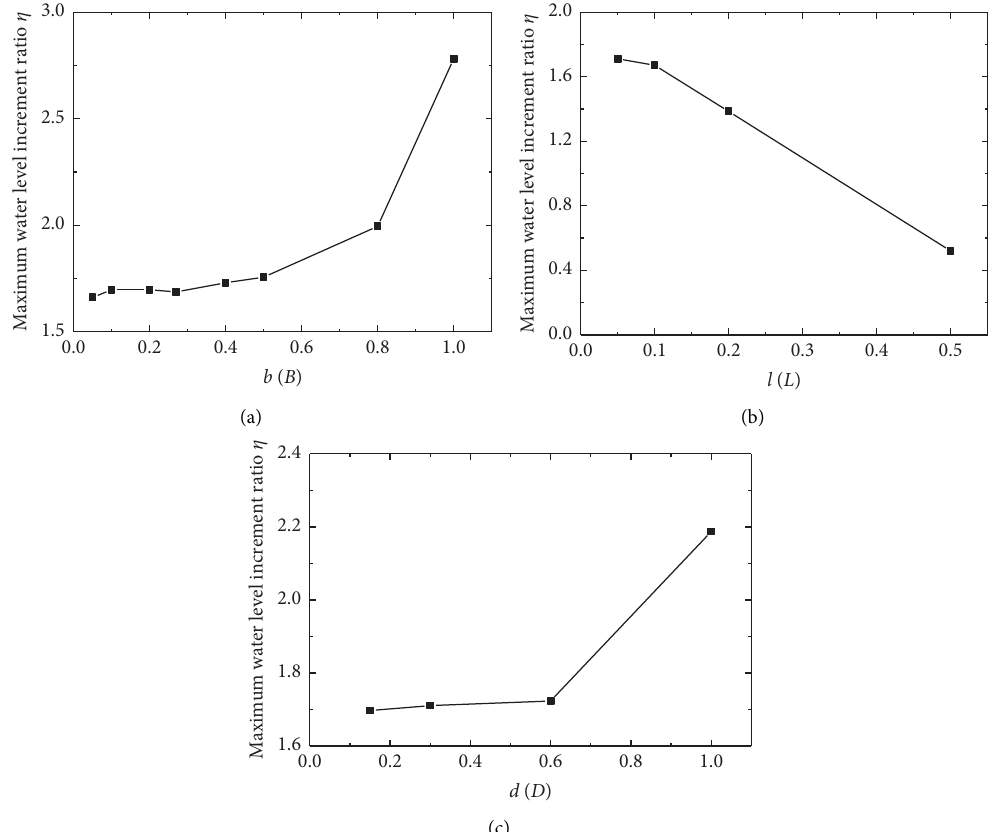
Figure 9: Variation in MWLIR with model relative dimension. (a) Infuence of width ratio b / B . (b) Infuence of length ratio l / L . (c) Infuence of height ratio d / D